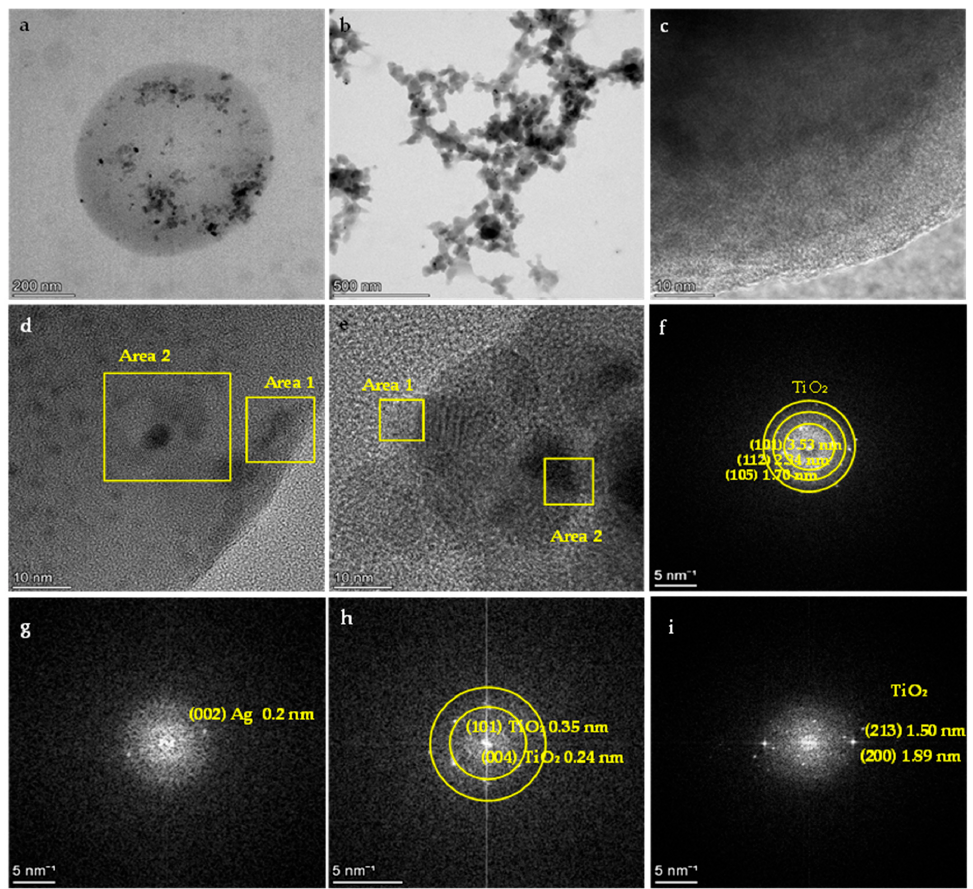
Figure 10. Transmission electron microscopy images of ( a ) the spherical particle of microgel with embedded Ag-TiO 2 nanoparticles, ( b ) the PNIPAM/PAA microgel Ag-TiO 2 NPs, ( c ) the outline of a microgel particle, ( d ) a microgel particle with embedded Ag-TiO 2 nanoparticles and lattice measurement spacing, ( e ) embedded Ag-TiO 2 nanoparticles with lattice measurement spacing, ( f ) TiO 2 nanoparticles, ( g ) Ag nanoparticles and ( h , i ) TiO 2 -decorated Ag nanoparticles.